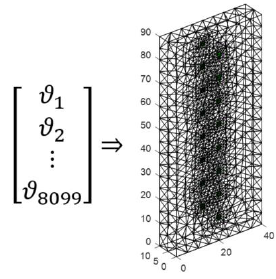
Figure 13. The way of converting a real number vector into the lightweight concrete block’s spatial image.